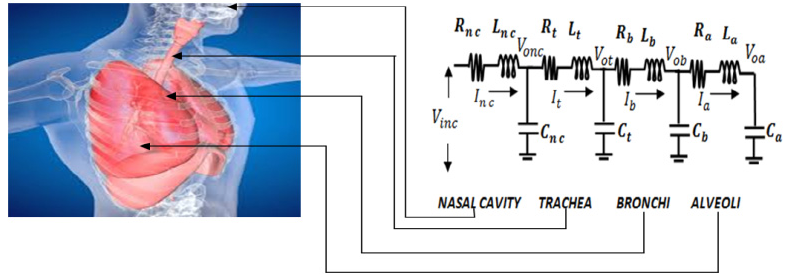
Figure 4. Equivalent electrical R, L, and C model of the human respiratory system.